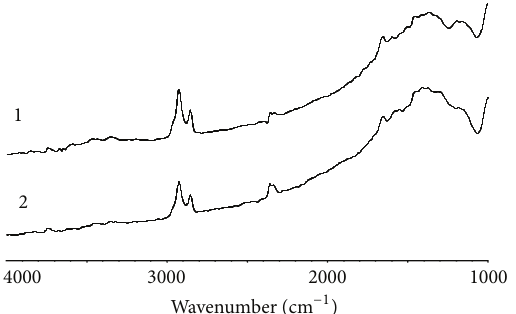
Figure 4: FTIR spectrum of alanine spot (trace 1) on a narrow band TLC plate. For comparison, a reference FTIR spectrum of pure alanine (trace 2) is also